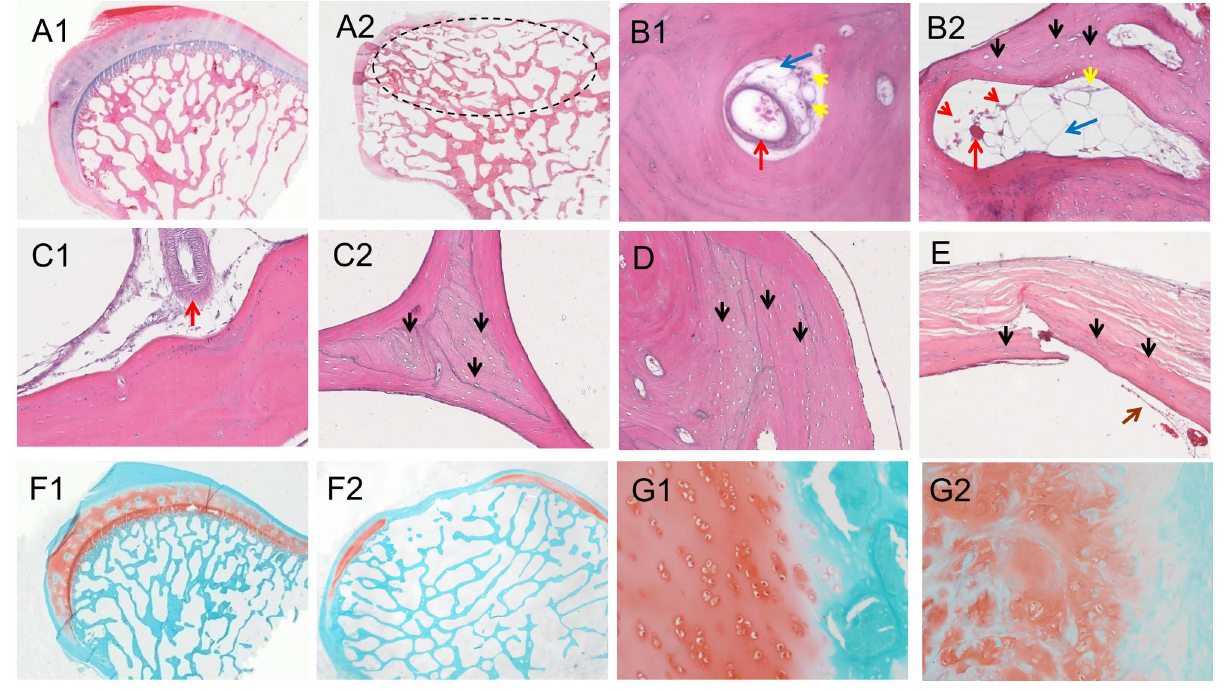
Figure 5. Representative histological images. H&E stained femoral heads of the control group (A1), and SAON group (A2) (dotted circle: collapsed region). Subchondral bone in the control group (B1), and in SAON group (B2) with empty lacunae (black arrows) in bone matrix, increased size and number of fat cells in bone marrow (blue arrows) and decreased number of mononuclear cells (yellow arrows) compressed blood vessel (red arrows) with effused blood cells (red arrowheads) when compared with that of the control group. Representative histological images at different regions of the femoral head: B: beneath the articular cartilage; C: central of the femoral head of normal group (B1, C1) and SAON group (B2, C2); and D: near to the femoral neck; E: fractured subchondral trabecular bone from a collapsed femoral head of SAON group, showing typical histological evidences of osteonecrosis, i.e., numerous empty lacunae or pyknotic nuclei of osteocytes (black arrows) and scattered bone marrow tissue (brown arrows). Safranin O stained femoral head in the control group (F1) and in SAON group (F2). Normal cartilage in the control group (F1) and pathological changes of articular cartilage in SAON group (F2). (10 6 for A1, A2, F1, F2; 200 6 for B1, B2, C1, C2, D, E, G1, G2). doi:10.1371/journal.pone.0076797.g005 PLOS ONE |